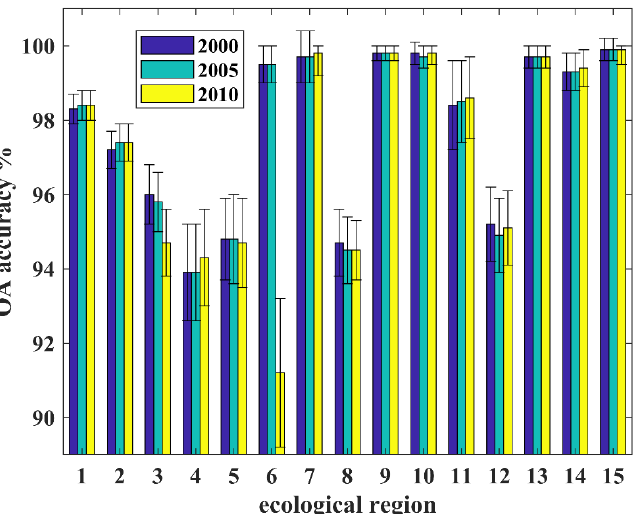
Figure 12. The OA of the different ecological regions for urban land from 2000 to 2010 at a 95% confidence level (1 – 16 denote the urban ecoregions corresponding to Figure 7).